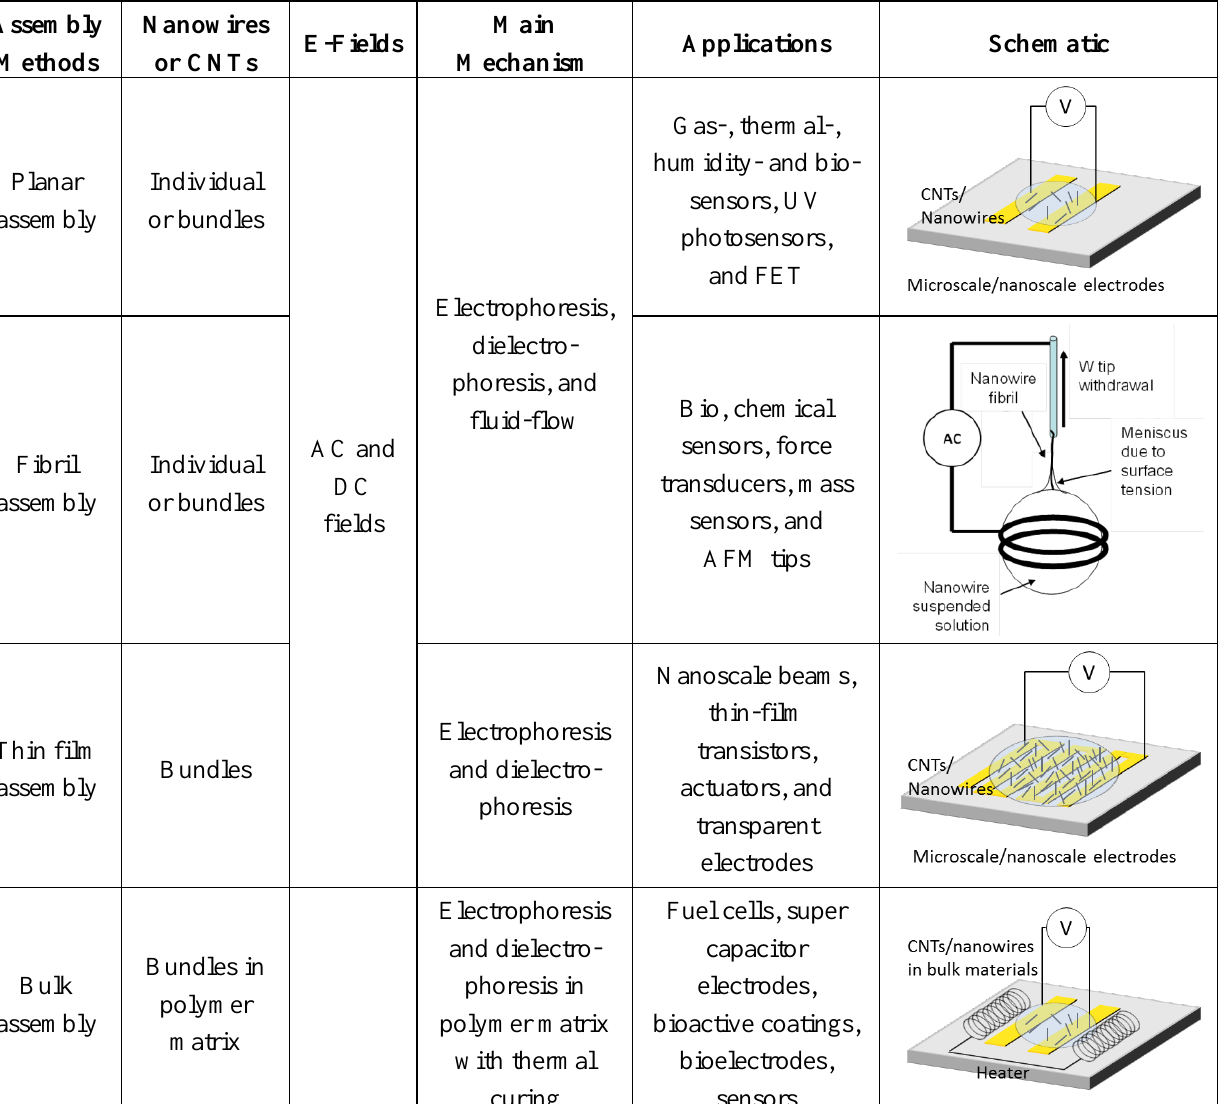
Table 2. Summary of electric field-induced assembly